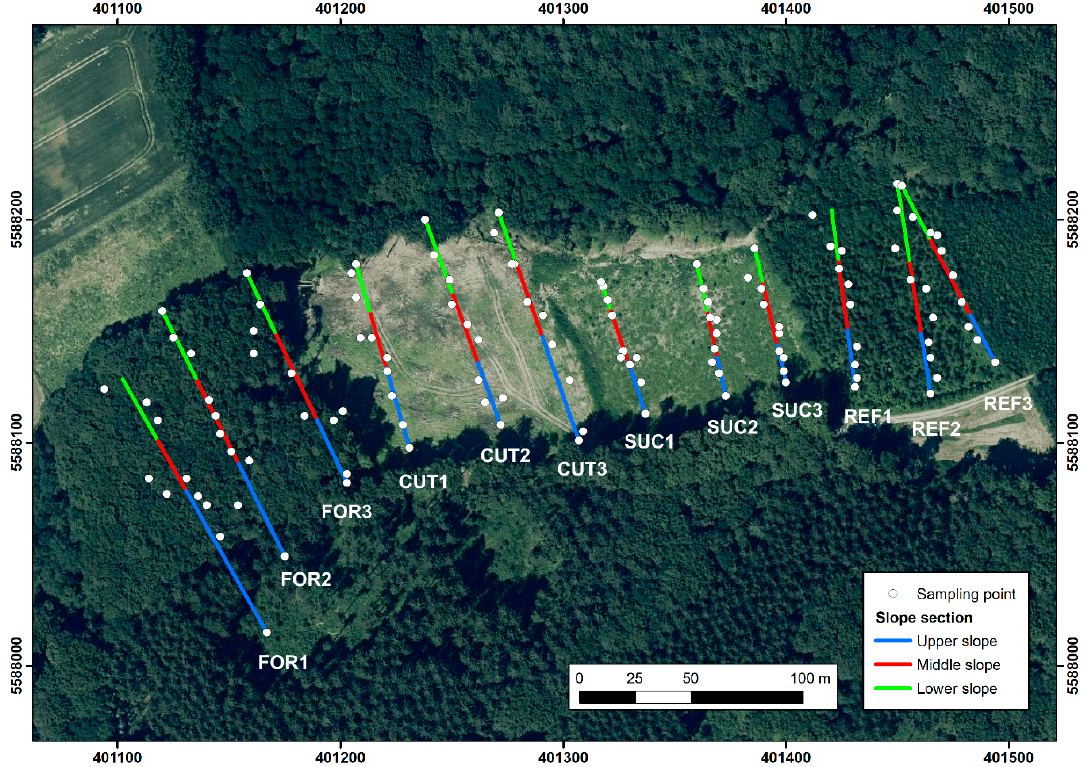
Figure 3. Study area, sampling point and catenae indicated. Catena labels refer to sub-areas: (FOR)ested, (CUT)-down, (SUC)cession, (REF)orested. Aerial photography by the Land Surveying State Office of Rhineland-Palatinate.